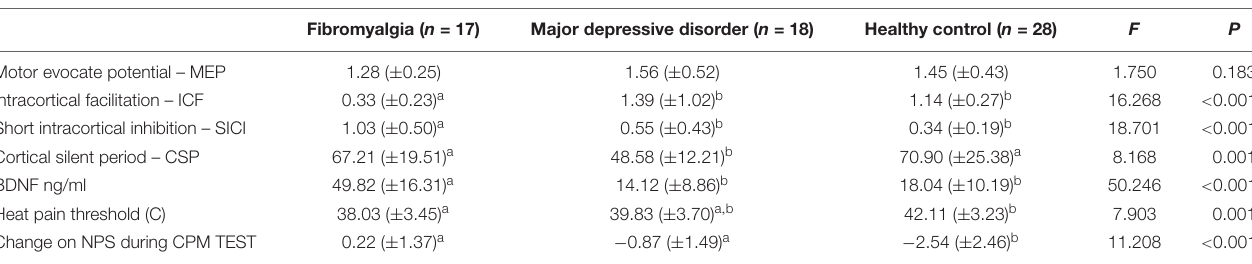
TABLE 2 | Cortical excitability measures assessed by the TMS, psychophysical pain measures, and